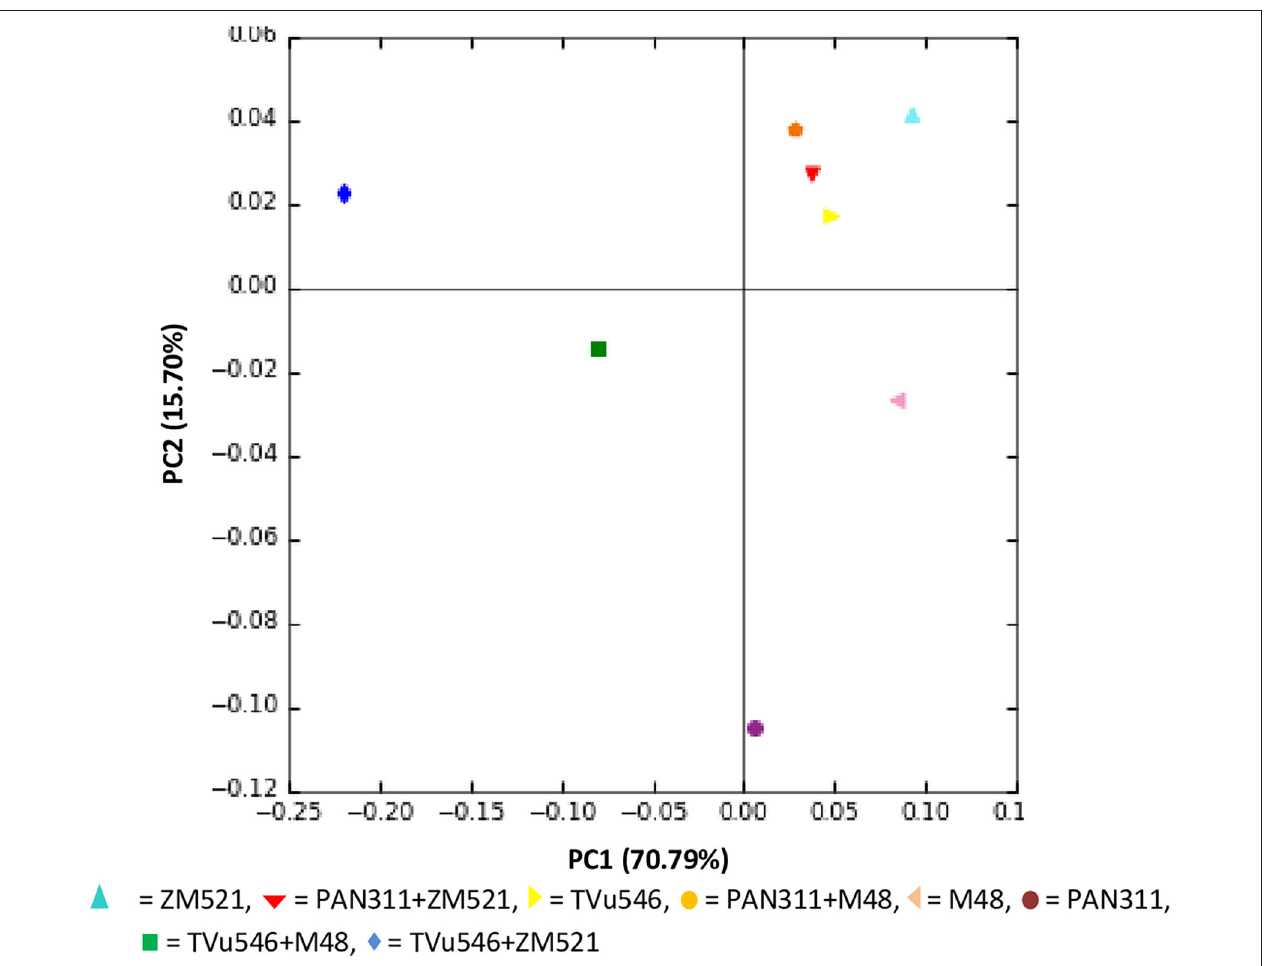
FIGURE 7 | Principal Co-ordinate analysis (PCoA) of microbial communities based on OTUs for all samples from rhizosphere of solo and intra-hole planted cowpea, sorghum, and maize.